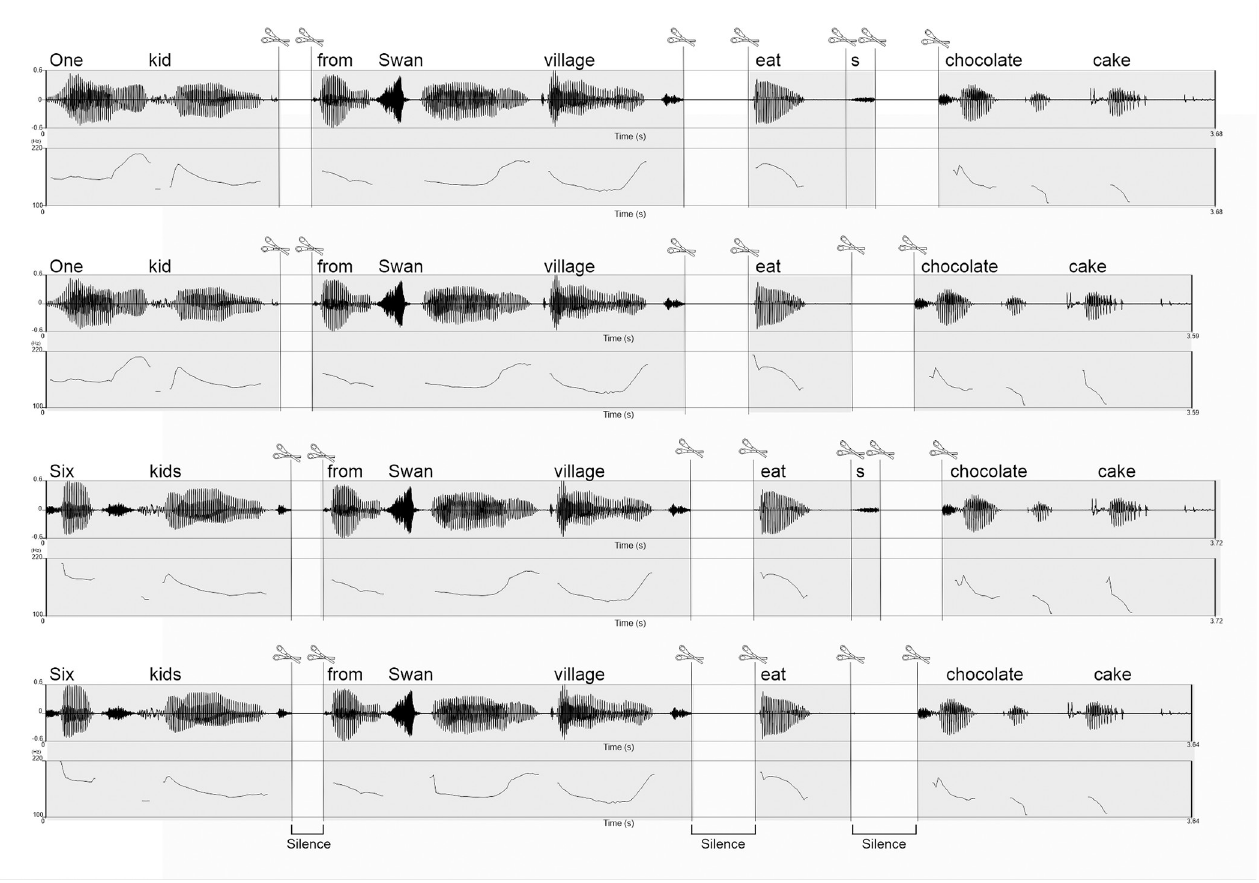
Fig 2. Example pitchtracks and illustration of the splicing procedure applied to the four experimental conditions tested in the auditory ERP experiment. Scissors indicate the positions where auditory files were appended. A 100 ms period of silence was inserted after “one kid” and “six kids”, and a 200 ms period of silence was inserted after “from Swan village” and “eat(s)”.